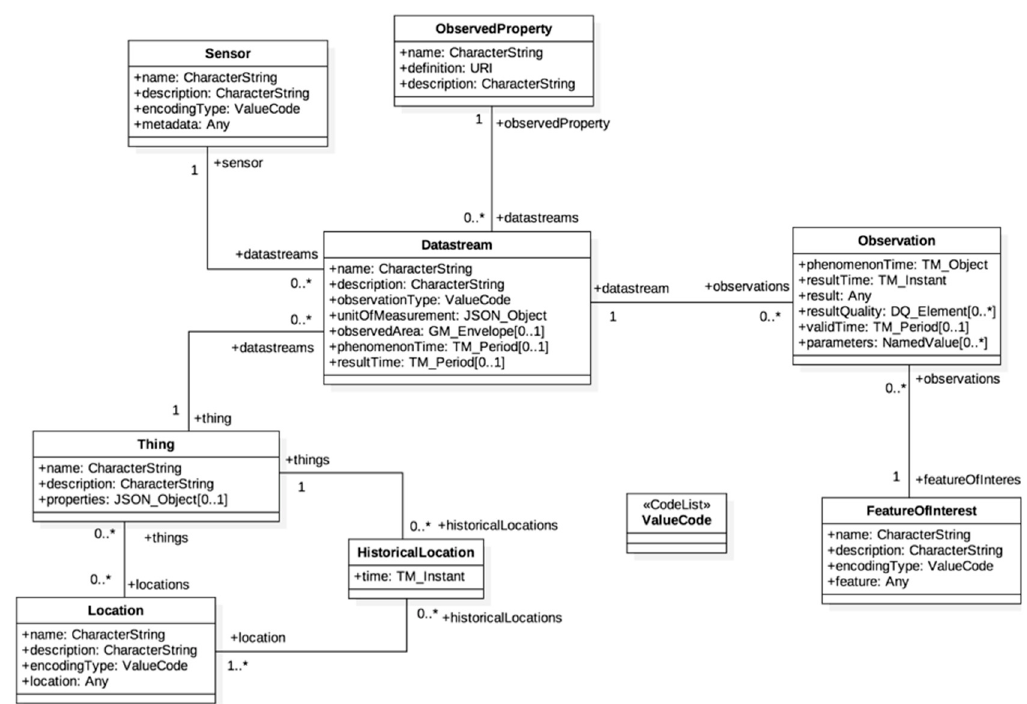
Figure 2. The SensorThings API UML diagram [14].